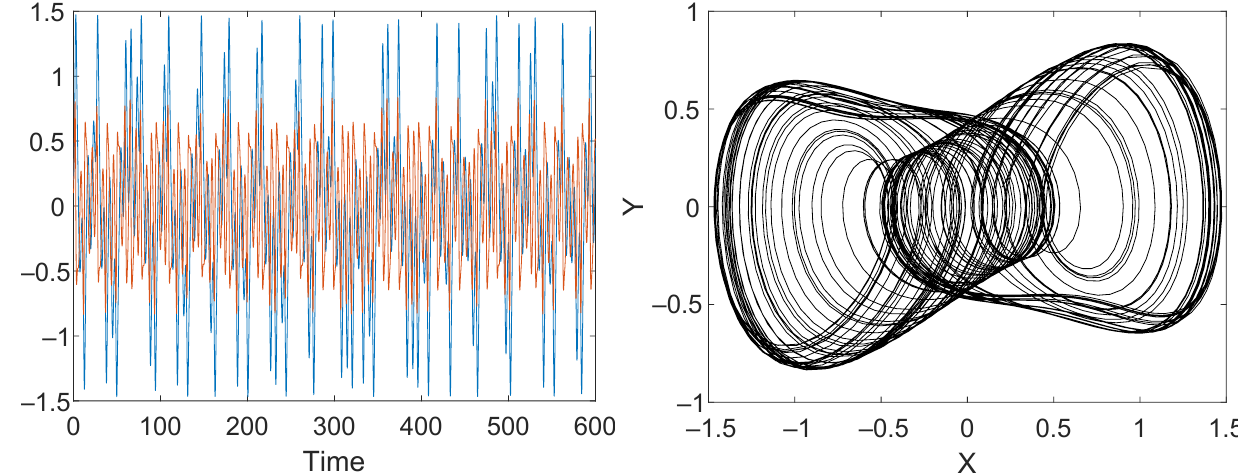
Figure 2. Time series of the classical Duffing-Holmes system and corresponding phase